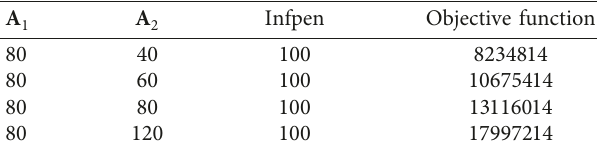
Table 14: Robustness analysis of the objective